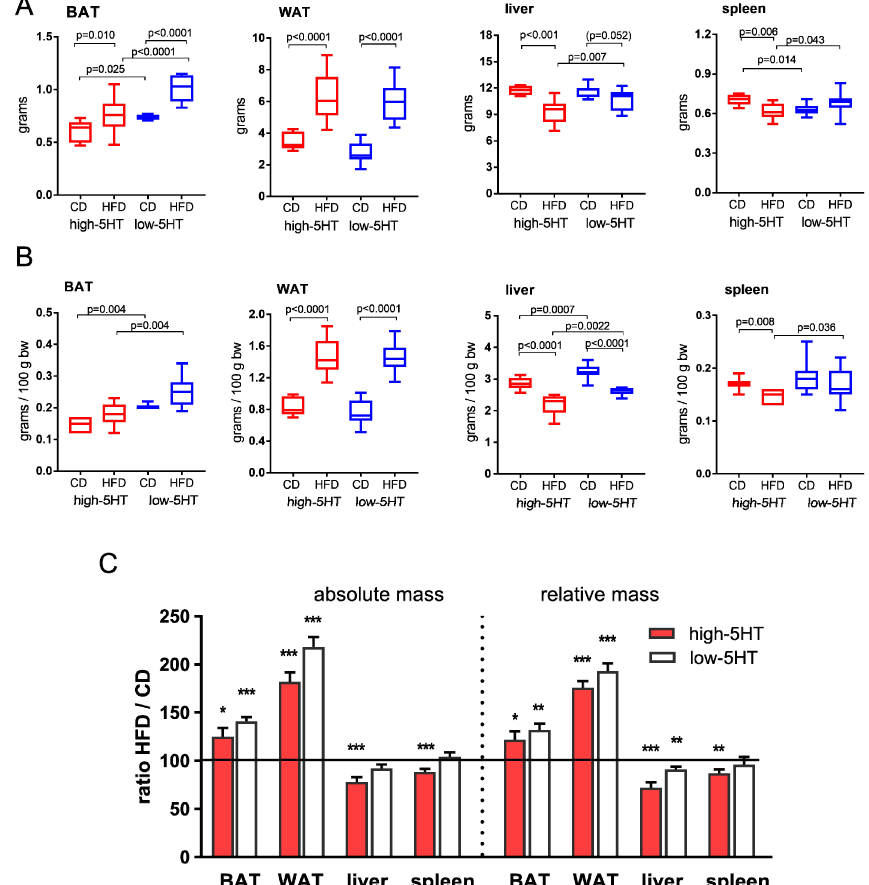
Figure 4. Organ mass in animals from high-5HT and low-5HT sublines at the end of 11 weeks of feeding with control diet (CD) or high–fat diet (HFD) expressed in grams per animal ( A ) or grams per body mass ( B ). Data are presented as median and min to max; N = 9 per group; p -values obtained by LSD or Dunn’s post-hoc test after one-way ANOVA or Kruskal-Wallis test are indicated. ( C ) Relative changes in organ mass presented as ratios (+standard error of the ratio) between HFD-fed and CD-fed animals of each subline. * p < 0.05, ** p < 0.01, *** p < 0.001 ( t -test or Mann-Whitney test, as appropriate). BAT = brown adipose tissue; WAT = gonadal white adipose tissue.